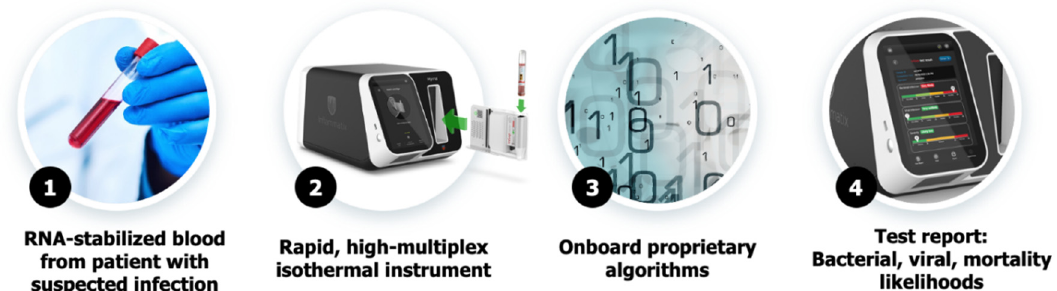
Figure 2. Workflow as presented for the InSep test from sample collection via PAXgene Blood RNA vacutainer ( 1 ) to loading of the cartridge into the instrument ( 2 ), processing on the instrument including the proprietary algorithm ( 3 ) and result reporting ( 4 ).